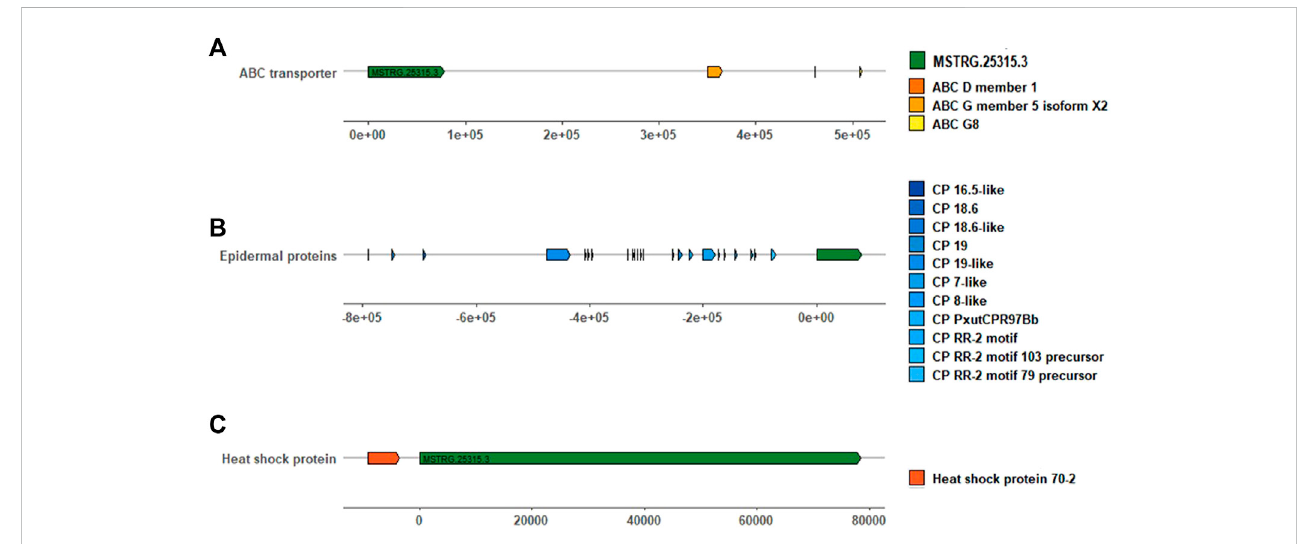
FIGURE 5 LincRNA MSTRG.25315.3 and its adjacent protein-coding genes involved in pesticide resistance within 1000 kb. (A) Green square represents MSTRG.25315.3 , and orange, brownish red, and yellow squares represent ABC genes. (B) Gradient blue squares represent different cuticle protein genes. (C) Red square represents the heat shock protein gene. The long solid line and the number marked above represent the distance (bp) between them, MSTRG.25315.3 and adjacent